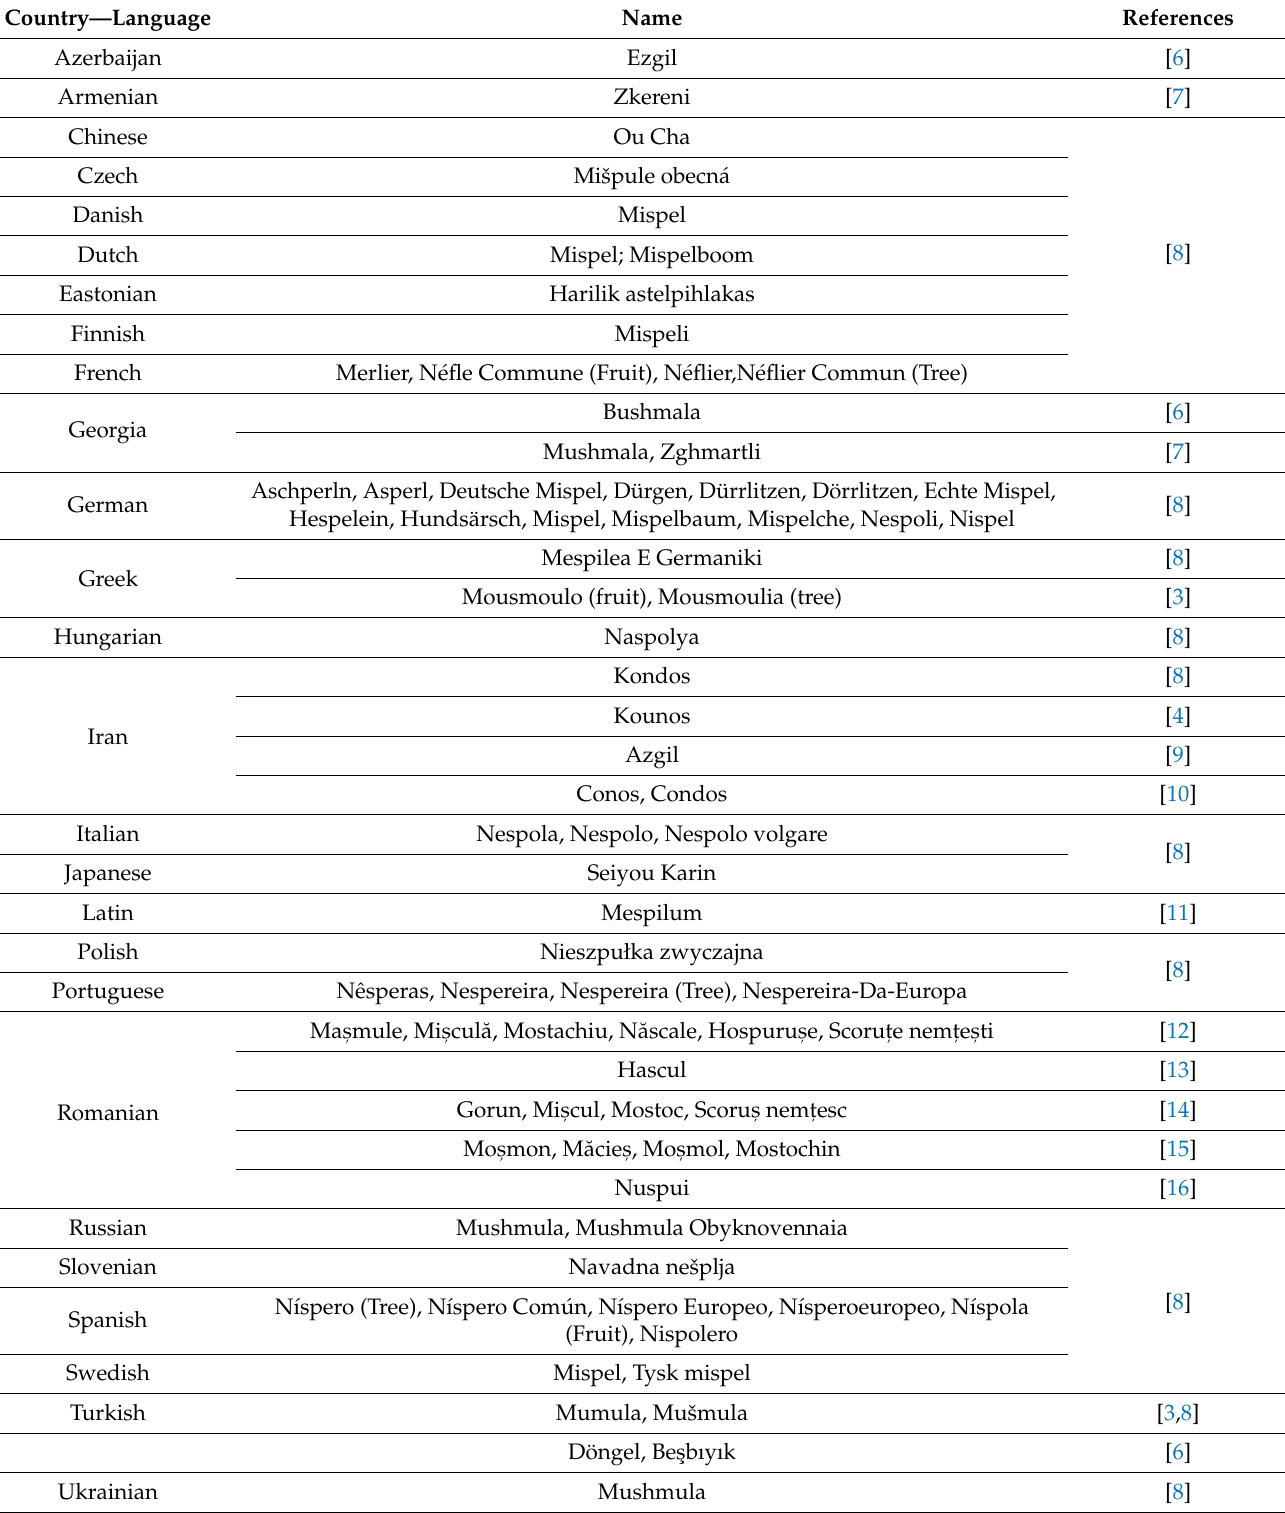
Table 1. Different names of medlar